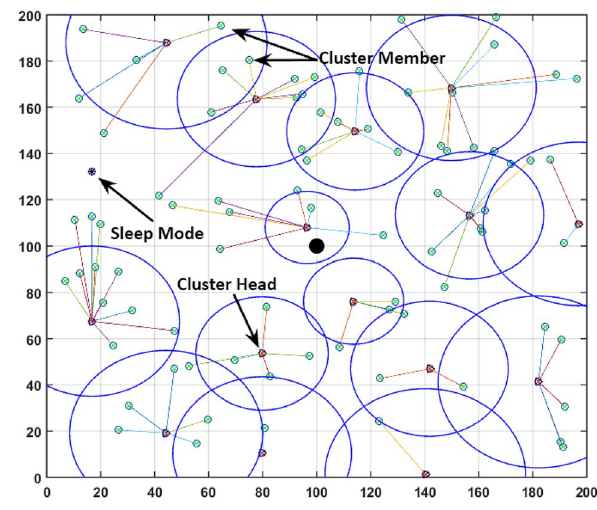
Fig. 4 WSN using the first proposed protocol in the fully-alert